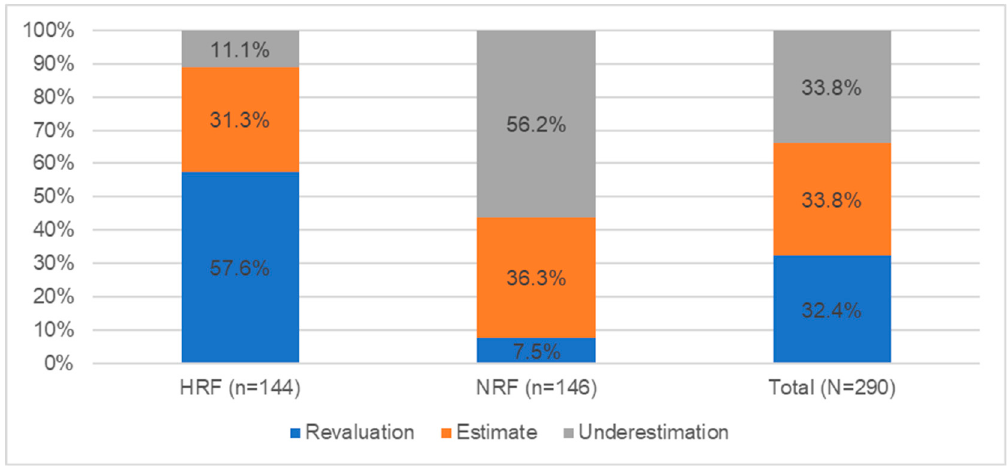
Figure 3. Level of portion size estimation across student groups (N =